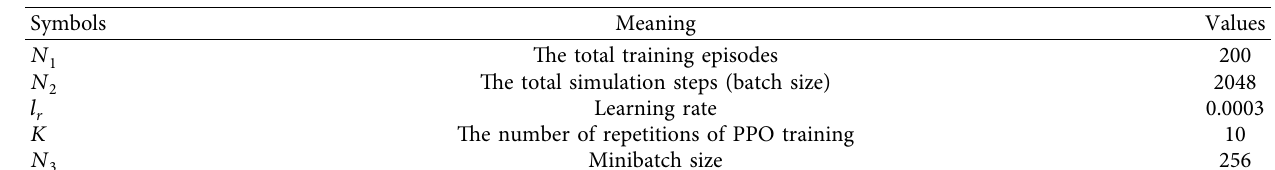
Table 2: Te hyperparameters.